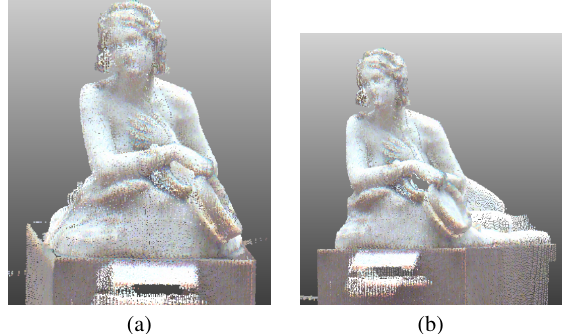
Figure 9. Two views of the 3D model obtained by means of TIMMS of the statue shown in Fig. 4.